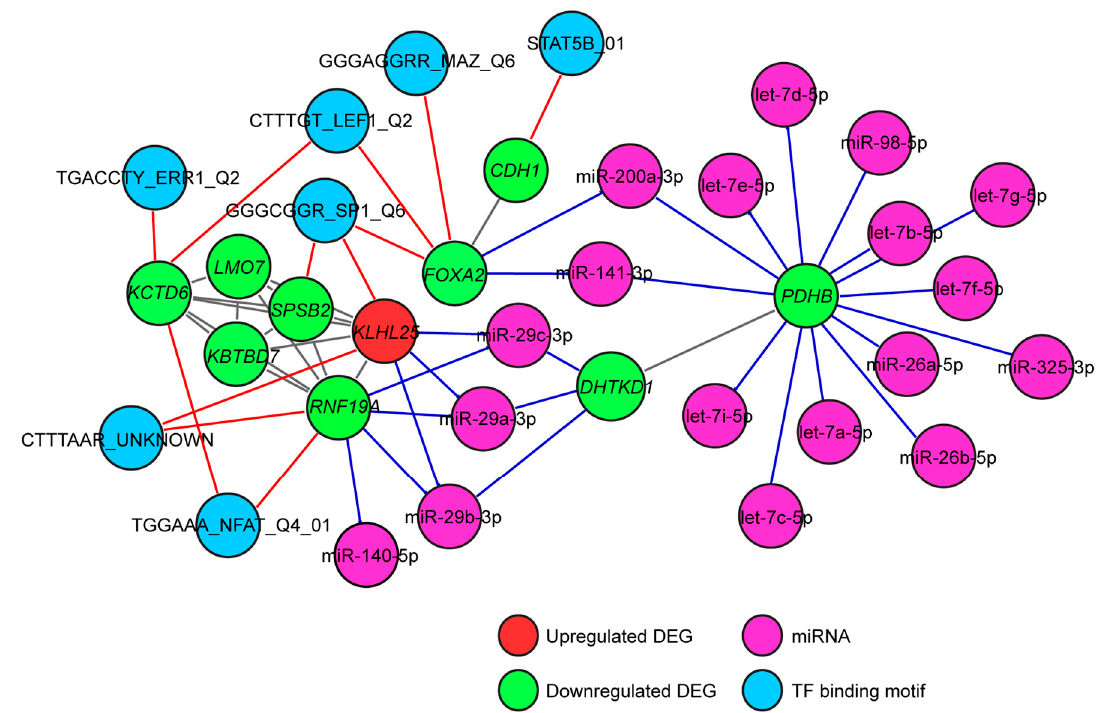
Figure 6. Gene regulatory network of the proposed gene biomarkers in NSCLC progression. A gene regulatory network for the biomarkers was constructed, and enriched transcription factors and miRNAs with a p < 0.01, corrected by BH FDR, were considered significant. Transcription factors associated with tumor progression and tumor suppressor miRNAs were found involved in the regulation of the gene biomarkers.